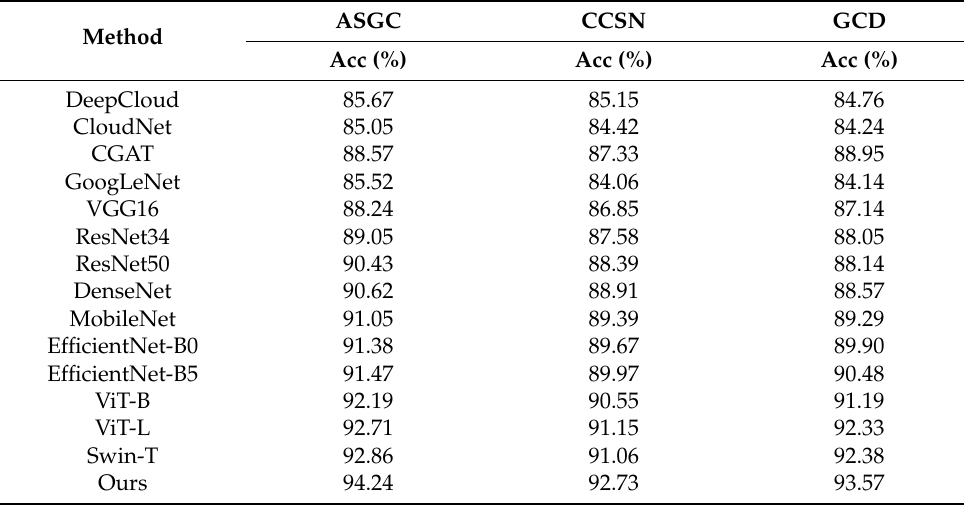
Table 8. The classification results of different methods based on different